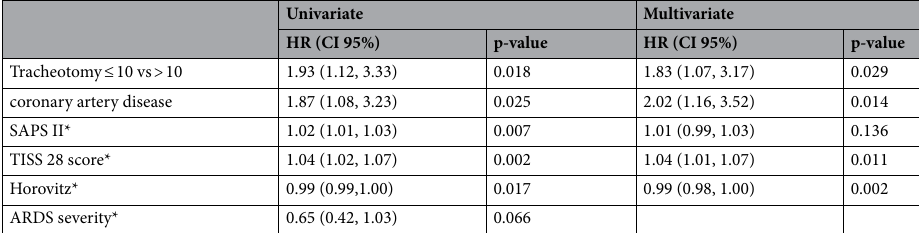
Table 2. Uni- and multivariate regression mortality analysis. Reproduction of the univariate and multivariate analysis of mortality in terms of the designated variables, including the confidence intervals and hazard ratio. ARDS, acute respiratory distress syndrome; CI, confidence interval; HR, hazard ratio; SAPS II, simplified acute physiology score; TISS 28, therapeutic intervention scoring system. * upon ICU